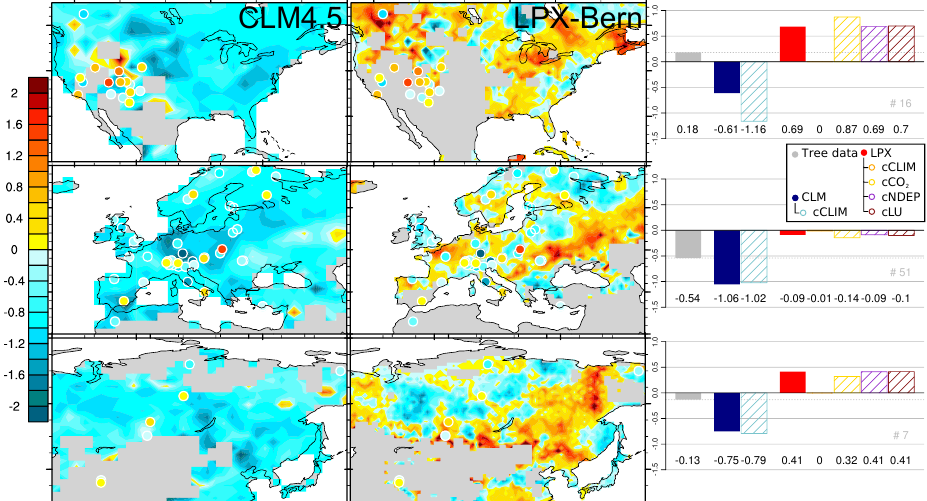
Figure 9. Same as Fig. 8 but for three selected regions. The bar plots show the regional average change in discrimination of C3 trees as calculated from tree-ring δ 13 C data (gray) and from results of the standard simulations of CLM4.5 (filled blue) and LPX (filled red) as well as from factorial runs (pattern). Individual driving factors (climate, CO 2 , N-deposition, and land use) were kept constant in the factorial runs, as explained in the main text and indicated by the legend. Model averages are computed from the mean grid-cell discrimination of C3 trees and for all model grid cells where tree-ring estimates are available. The number of available tree-ring records is